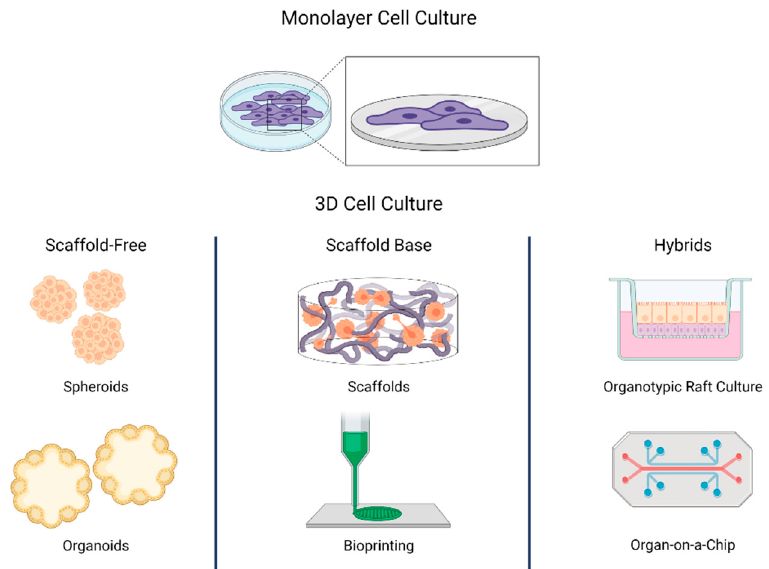
Figure 1. Scheme of diverse 3D cell culture strategies (i.e., scaffold-free, scaffold-base, and hybrids). In monolayer cell culture, cells grow attached to a plastic base. In 3D cell culture, cells self-assemble or grow in structures that resemble the extracellular matrix. The 3D cell culture can be divided into three groups: scaffold-free, scaffold base, and hybrids. In scaffold-free systems, cells aggregate as occurs in natural processes of organogenesis. Scaffold-based systems use structures that mimic the extracellular matrix. Hybrids use a matrix or a scaffold to support scaffold-free